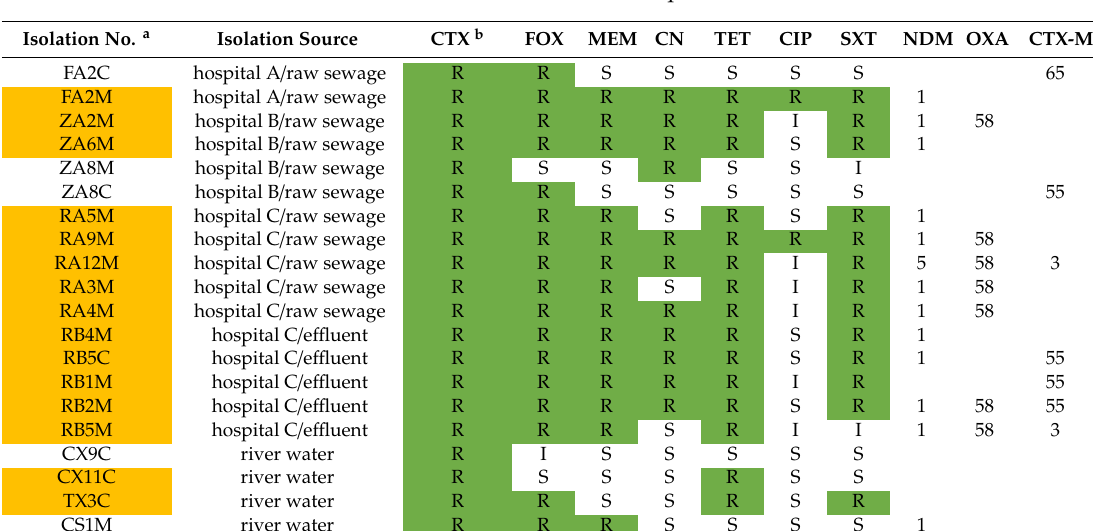
Table 2. Acinetobacter strains isolated from aquatic